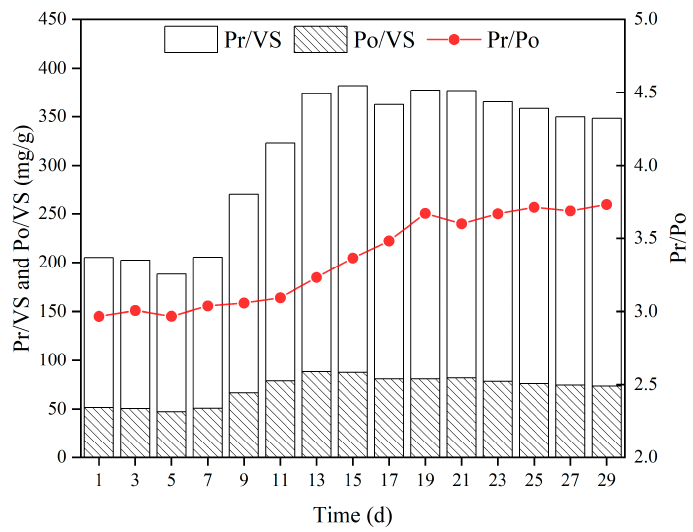
Figure 4. Variation of EPS during the start-up period of MBBR.